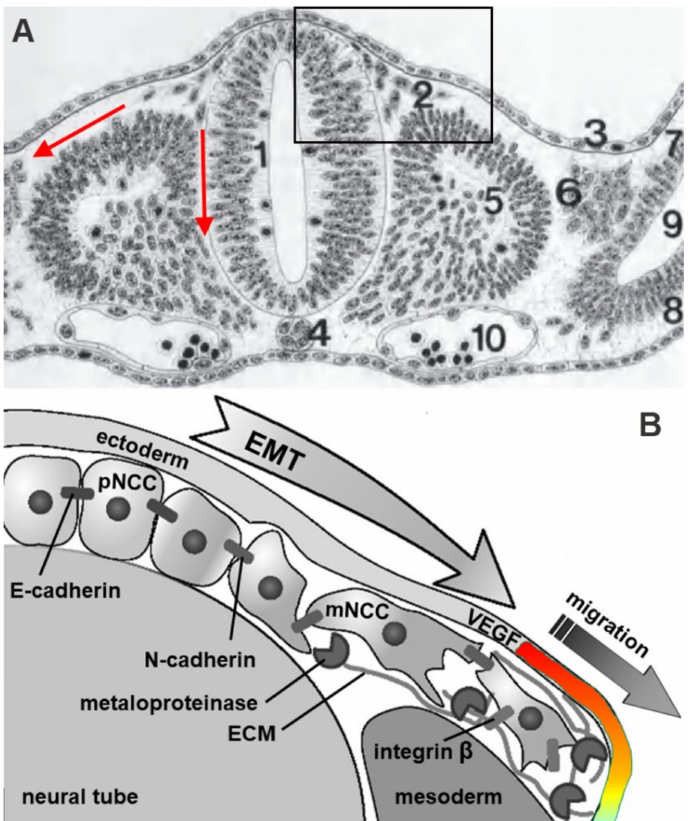
Figure 2. Delamination of NCCs from neuroectoderm via ectodermal-mesenchymal transition and migration of NCCs via ventrodorsal and ventromedial pathways. Cross-section through a human embryo on day 24 of gestation (crown-rump length 3 mm). The lower part of figure ( B ) represents enlarged inset from the upper part ( A ). Legend: 1, neural tube; 2, neural crest migratory cells; 3, ectoderm; 4, dorsal chord (notochord); 5, somite; 6, intermediate mesoderm; 7, somatopleura; 8, splanchnopleura; 9, intraembryonic whole; 10, aorta; a red medial (vertical) arrow between the neural tube and the somite indicates the ventromedial direction of NCCs migration, a red lateral arrow between the ectoderm and the somite indicates the dorsolateral direction of NCCs migration; ECM, extracellular matrix; EMT, epithelial-mesenchymal transition; mNCC, migratory neural crest cells; pNCC, premigratory neural crest cells, VEGF, vascular endothelial growth factor. The spatio- temporal expression pattern of VEGF in the ectoderm (colored) regulates the NCCs migratory front. The upper part of figure ( A ) is from Christ (1985) [32], and the lower part of the image is schematized according to Szabo and Mayor (2018) [31] and McLennan et al. (2010) [33]. Anteroposterior positional identity of premigratory NCCs in all vertebrates is